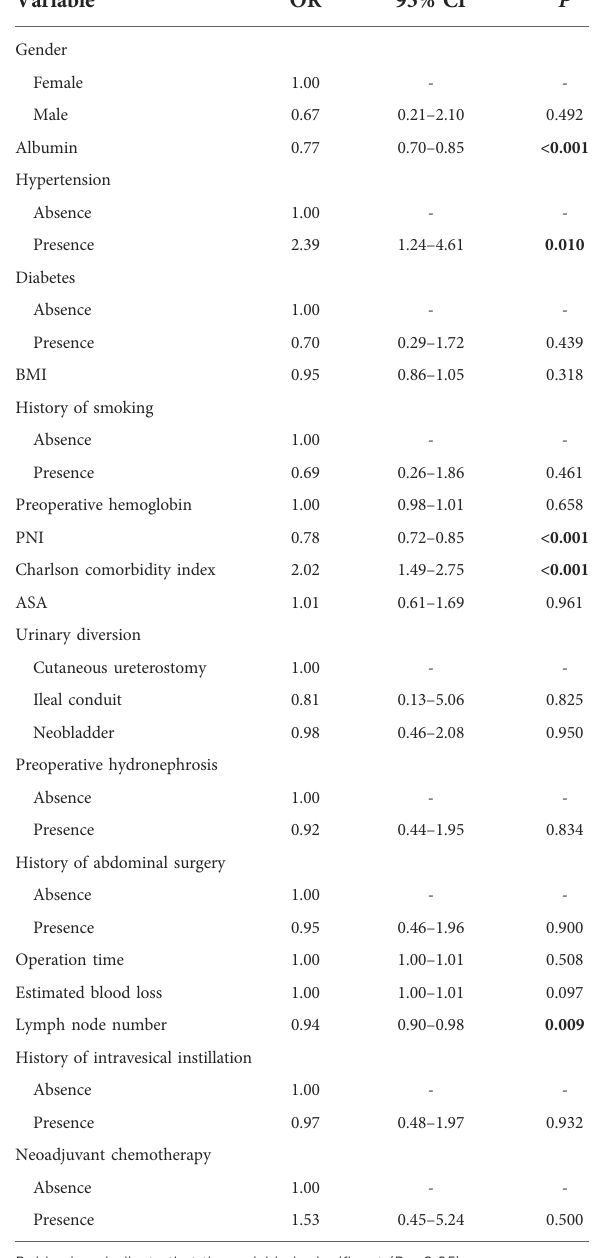
( Table 4 ). The forest plot of multivariate analysis was shown in Figure 3 . The univariate and multivariate analysis results were also shown in Supplementary Tables S1, S2 . The results